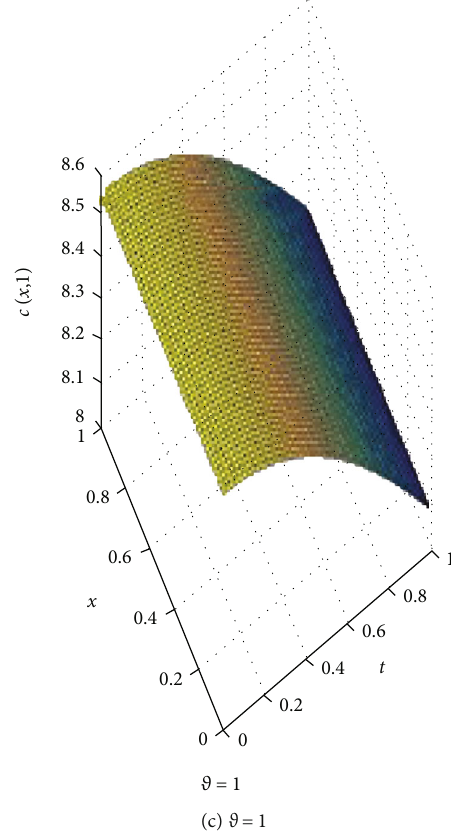
Figure 3: Variation of the concentration C ð x , t Þ with the fractional parameter α for μ = : 01